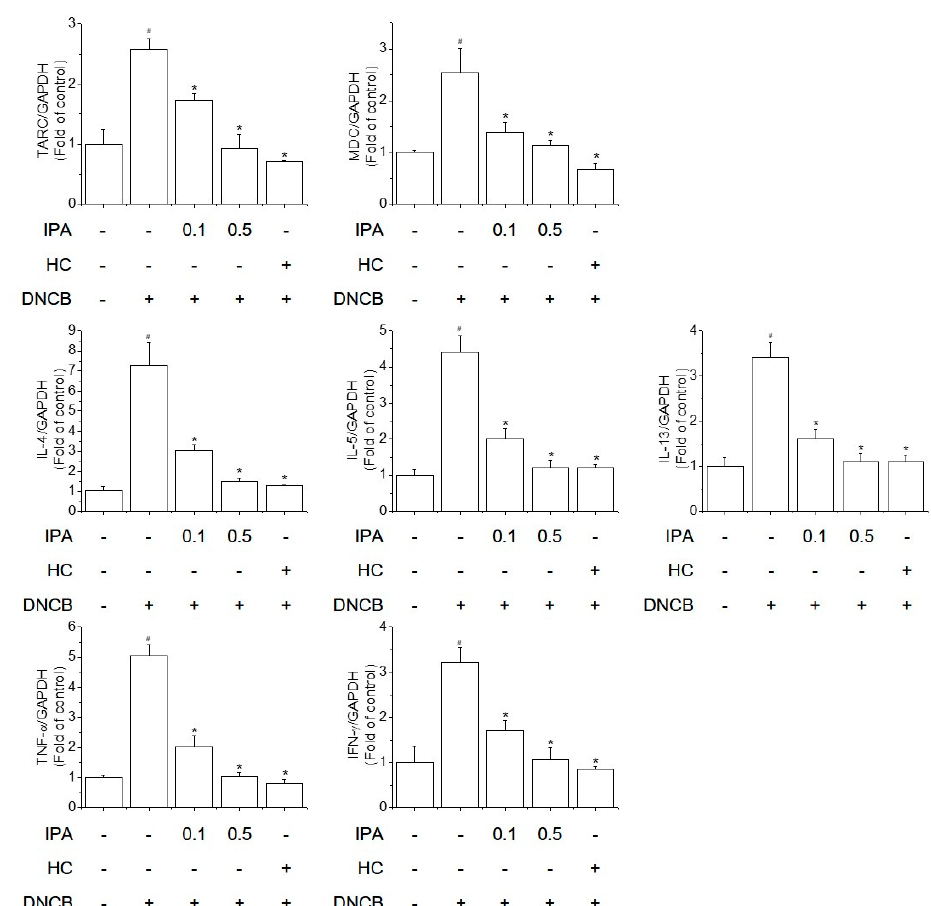
Figure 3. Inhibitory effect of IPA on the DNCB-induced increased serum concentration and mRNA level of thymic stromal lymphopoietin (TSLP) in BALB/C mice. ( A ) Serum TSLP concentra- tions were assessed by ELISA. ( B ) TSLP mRNA level was assessed by real-time PCR. Results are means ± SD (n = 6). # p < 0.05, versus the control group; * p < 0.05, versus the DNCB-treated group.